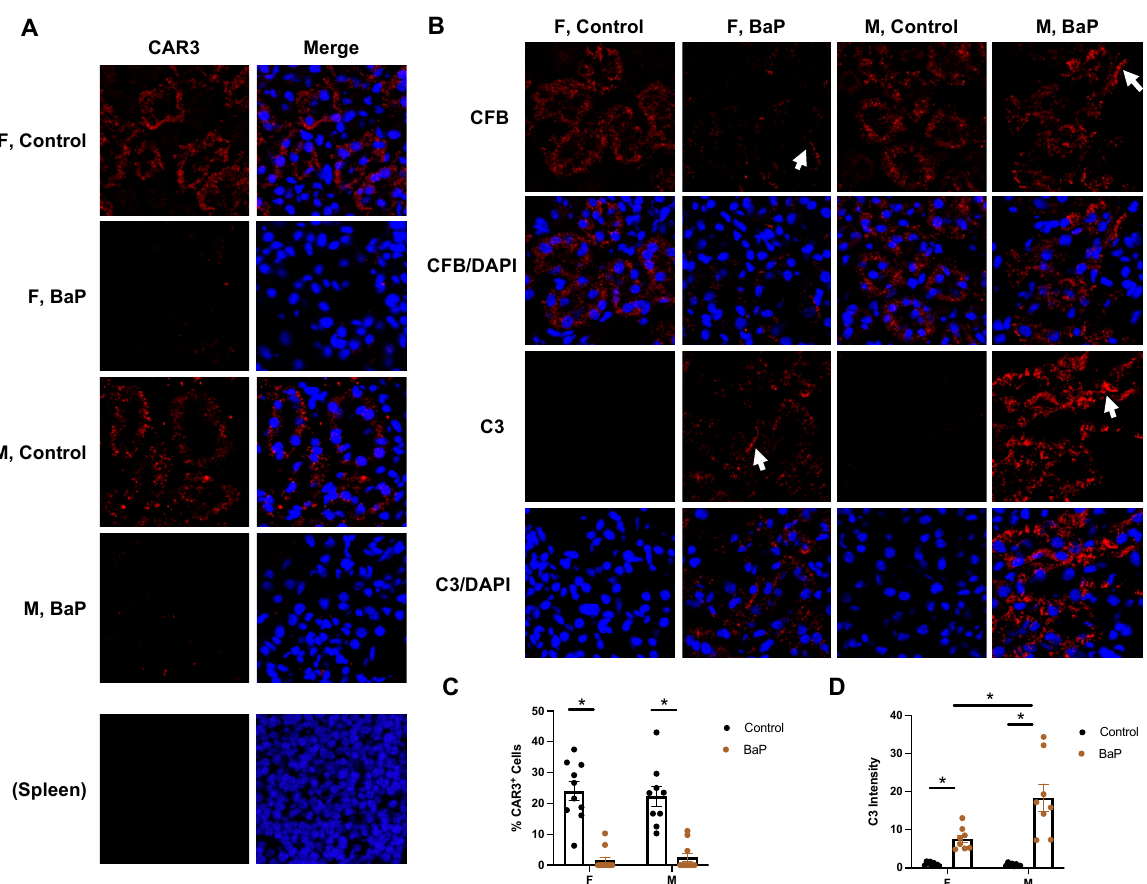
Figure 7. BaP-caused loss in renal tubule cell subtypes associated with an increase in C3 deposition. ( A ) Immunostaining of CAR3 in female or male control- or BaP-treated kidney, with staining in the spleen as a negative control and with quantification in ( C ) (20×). ( B ) Immunostaining of CFB and C3 in female or male control- or BaP-treated kidney, with arrows pointing to fibrils formed and quantification in ( D ) (20×). F, female. M, male. Control, vehicle-treated. BaP, BaP-treated. *, p < 0.05, Student’s t -test.